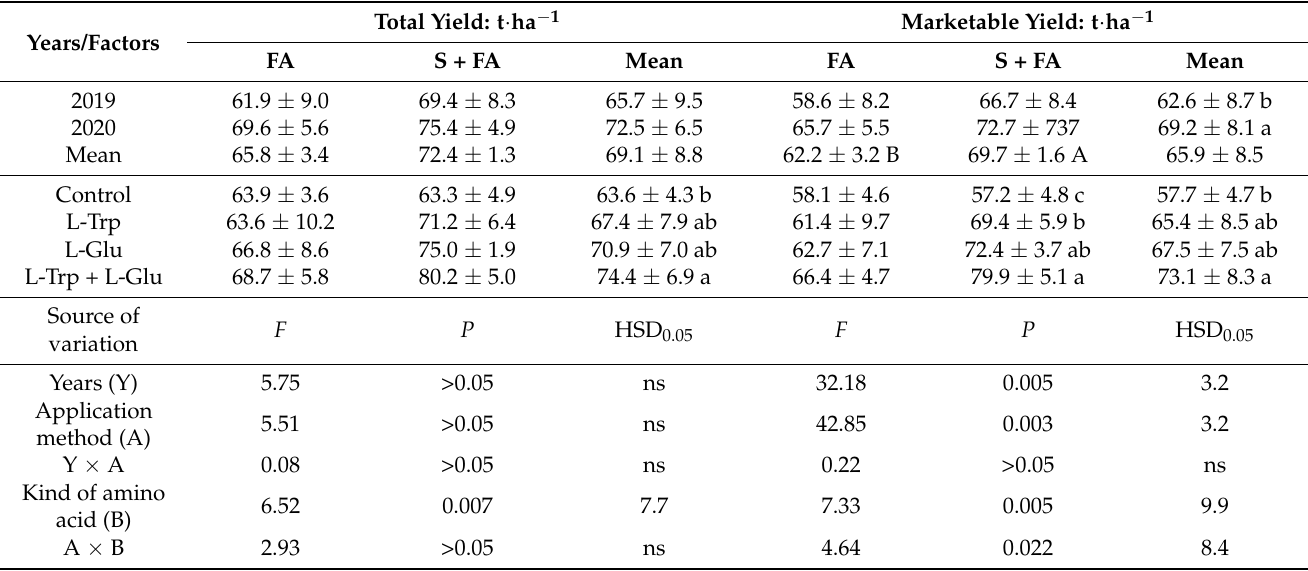
Table 4. The effect of L-tryptophan and L-glutamic acid, methods of their application, and years on the total and marketable yield of carrot storage